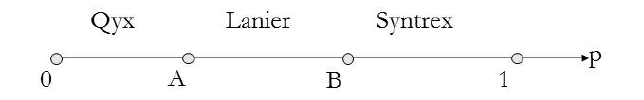
Figure 1. The best Choice for word processing equipment by the difference method,